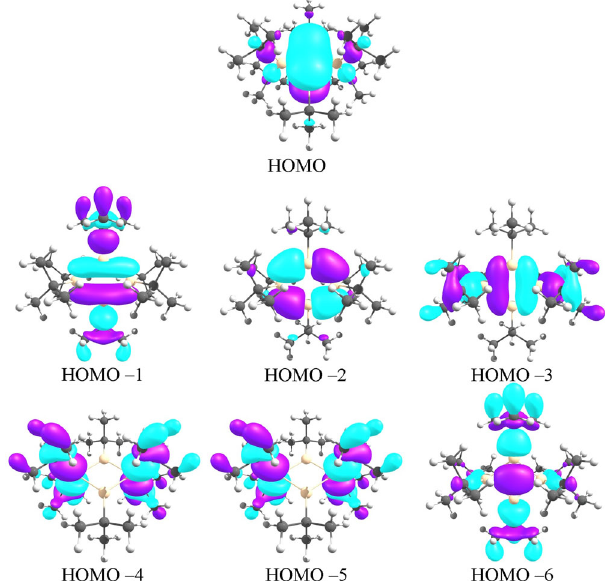
Fig. 1 Occupied molecular orbitals. Occupied molecular orbitals of 2 ; HOMO − 6 corresponds to a σ -bond across the